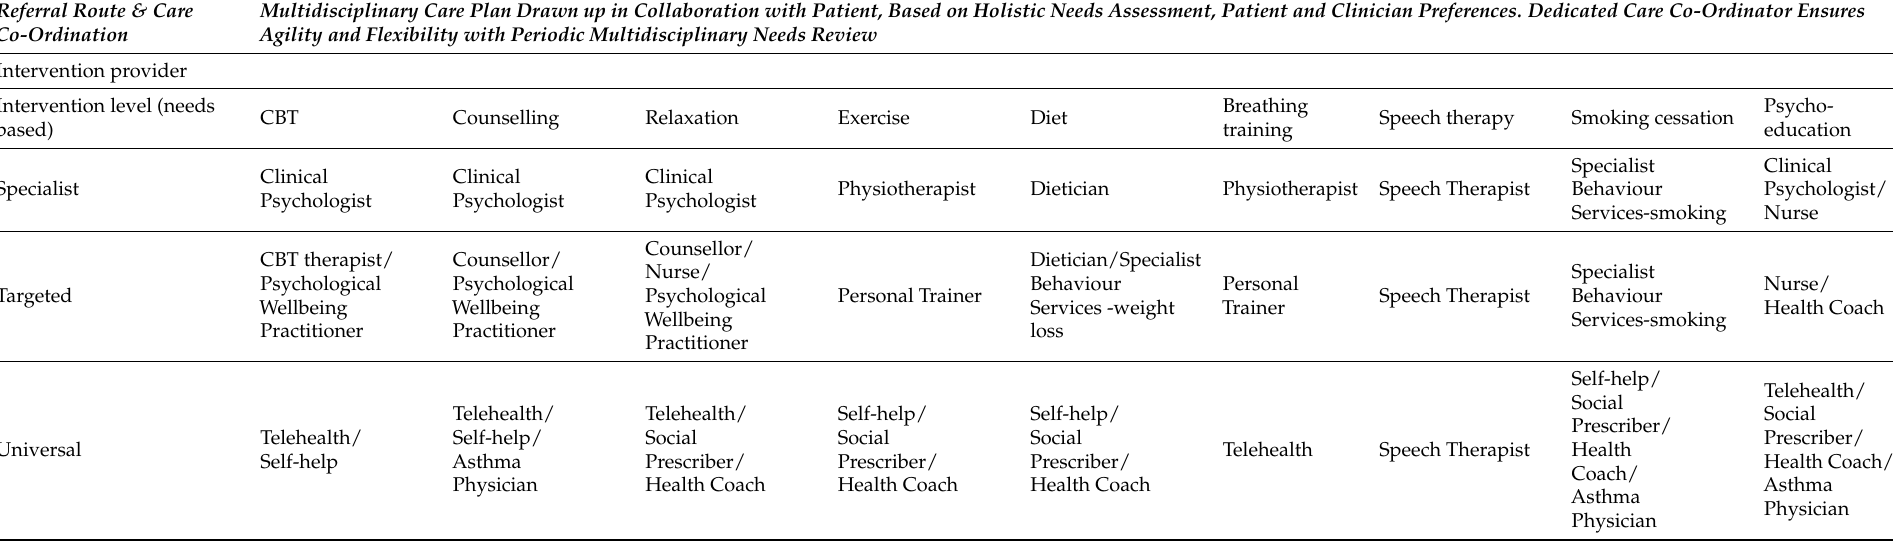
Table 2. Proposed model of non-pharmacological intervention provision for treatable traits in patients living with Difficult Breathing